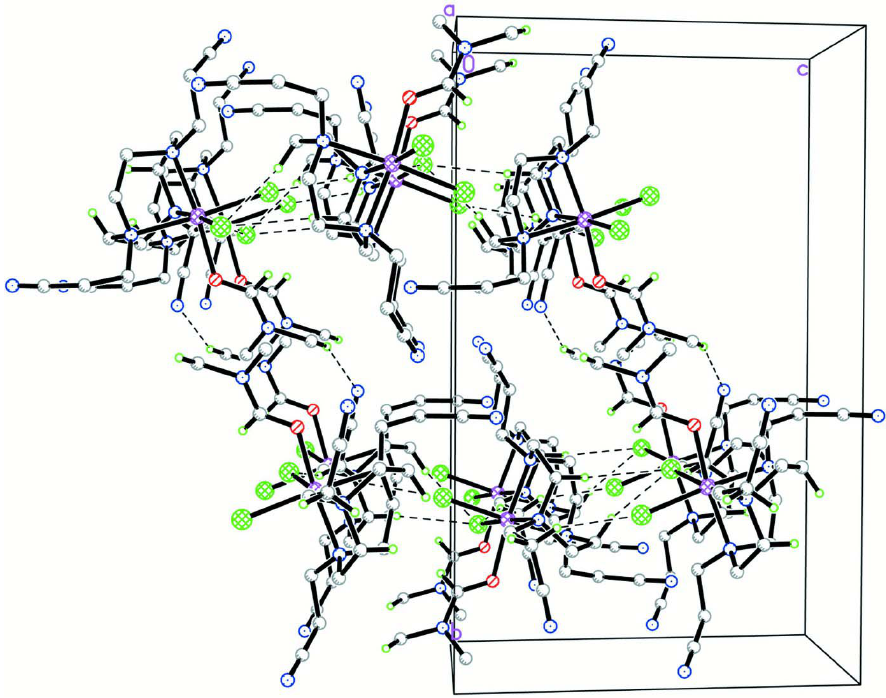
Figure 2 Packing diagram of the title compound, showing the three-dimensional network formed through intermolecular C— H···Cl and C—H···N hydrogen bonds (dashed lines). For clarity, H atoms not involved in hydrogen bonding have been